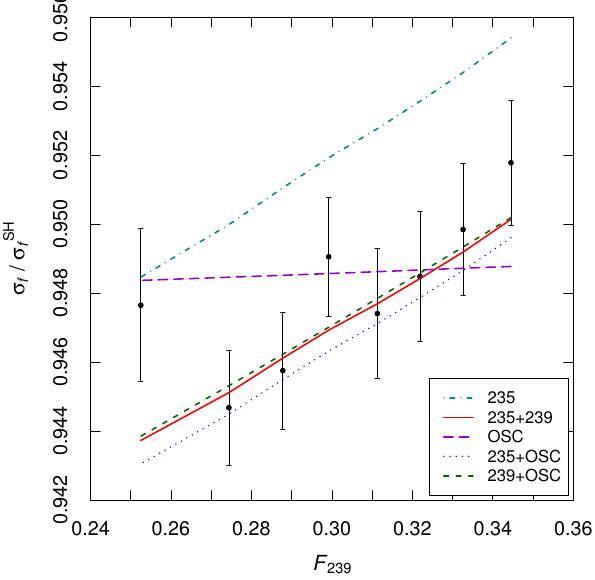
Figure 1 . Fits of the Daya Bay evolution data [11] normalized to the Saclay-Huber theoretical predictions [4, 5, 9]. The error bars show only the uncorrelated statistical